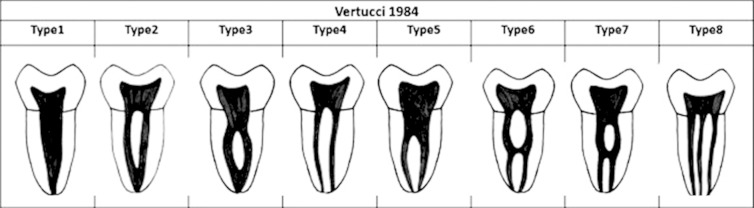
Vertucci’s (1984) criteria for the classification of root canal morphology.